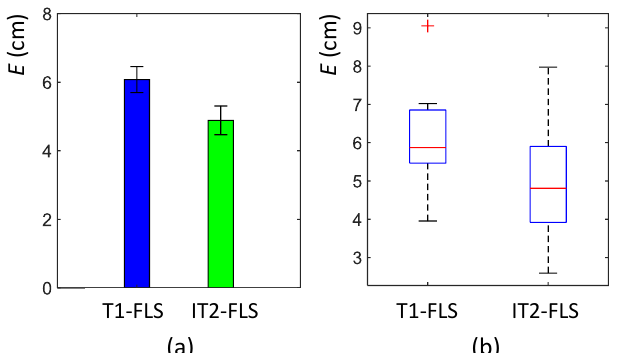
Figure 11. ( a ) Mean of average lateral error, E , during the test cases of the second phase of validation. The error bars are drawn to represent the standard error. ( b ) The corresponding box plot of E . The box plot has the usual standard notation; box: interquartile range, horizontal line: median, whiskers: minimum and maximum, and plus sign: outliers.